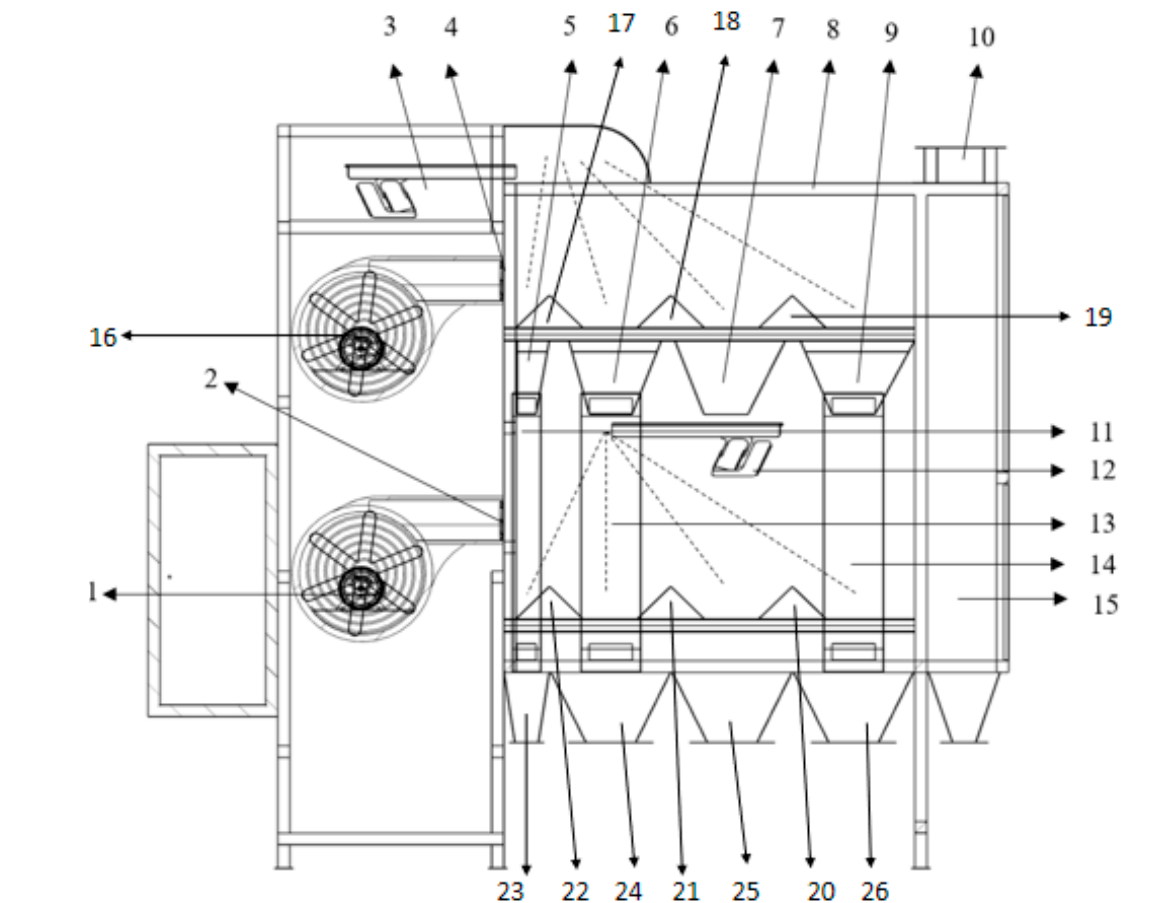
Figure 3. Schematic diagram of double-layer tea winnowing machine. 1, Lower fan; 2, Lower wind outlet; 3, No. 2 vibratory feeder; 4, Upper wind outlet; 5, No. 1 upper-level material outlet; 6, No. 2 upper-level material outlet; 7, No. 3 vibratory feeder; 8, wind outlet No. 1; 9, No.4 upper-level ma- terial outlet; 10, wind outlet No. 2; 11, Guide tube No.1; 12, No. 3 vibratory feeder; 13, Guide tube No. 2; 14, Guide tube No. 3; 15, Dust chamber; 16, Upper fan; 17, No. 1 baffle; 18, No. 2 baffle; 19, No. 3 baffle; 20, No. 4 baffle; 21, No. 5 baffle; 22, No. 6 baffle; 23, No. 1 lower-level material outlet; 24, No. 2 lower-level material outlet 25, No. 3 lower-level material outlet; 26, No. 4 lower-level ma- terial outlet.